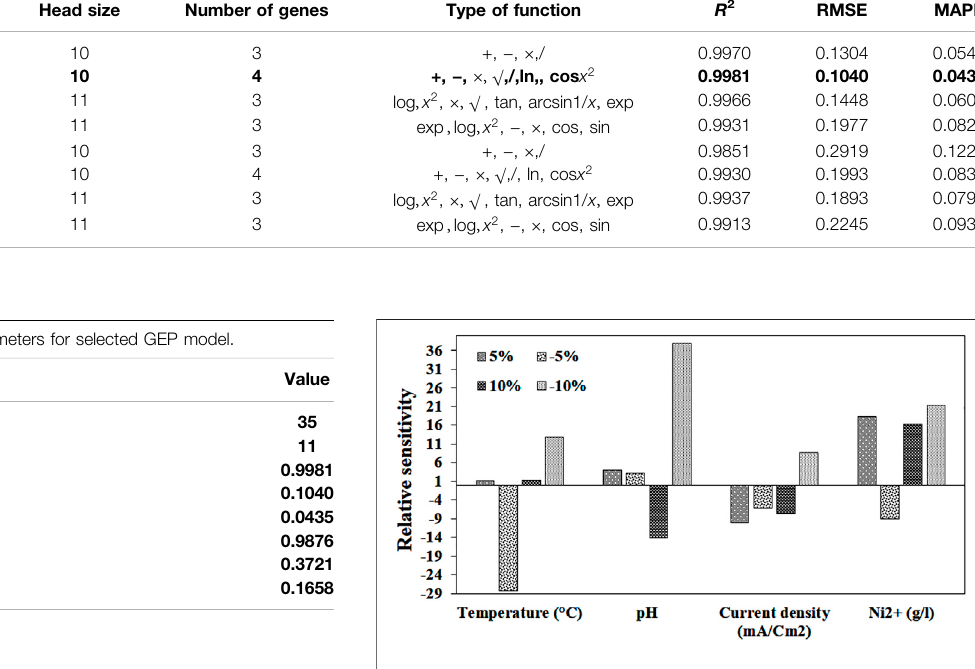
FIGURE 9 | Result of GEP models: (A) R 2 , (B) RMSE, and (C)